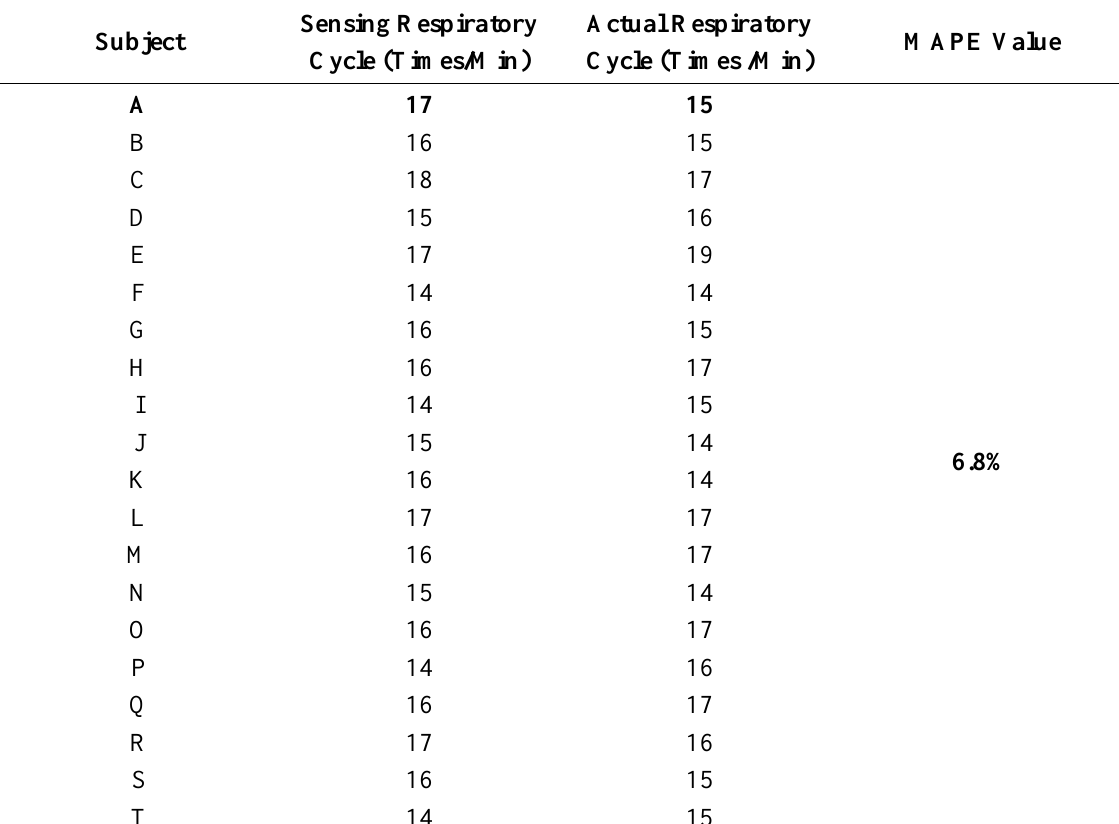
Table 14. Respiratory rate measurement results.